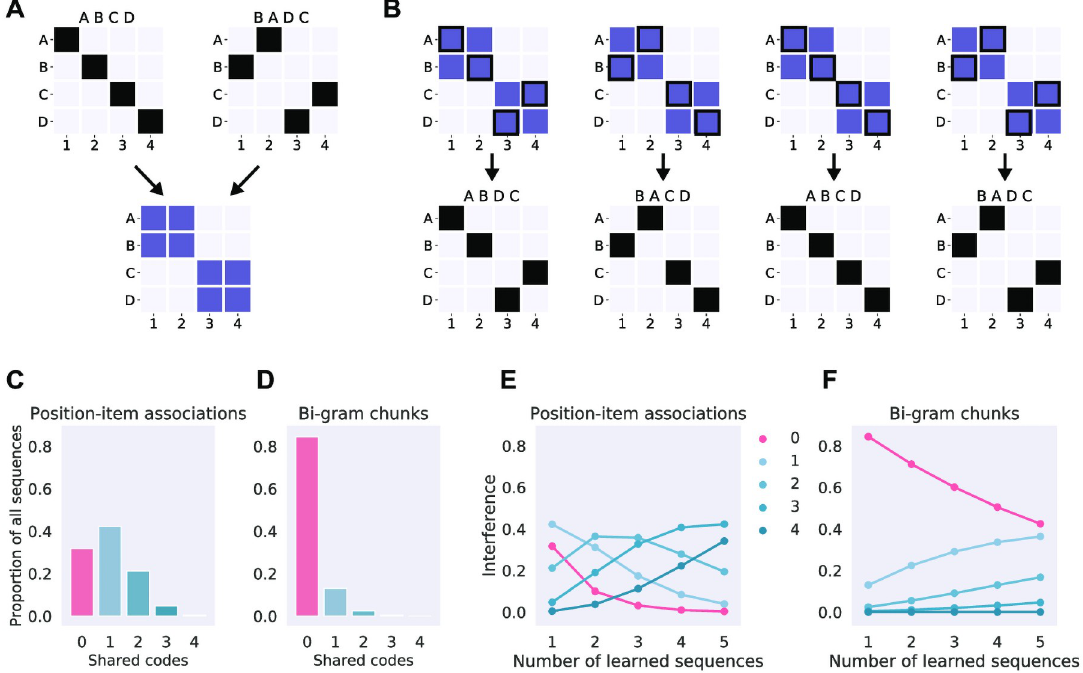
Fig 7. Interference in sequence learning. (A) Visual representation of two sequences as position-item associations (top) and the resulting frequency of associations (bottom) as defined by the associative sequence learning model. (B) Associative learning of two sequences on panel A would boost the representations of four individual sequences despite the statistical regularities being extracted from only two. See S4 Text for a worked example. (C) Histogram of the expected number of shared codes (item-position associations, x- axis) for a single 4-item sequence with all other possible 4-item sequences ( n = 256, allowing repeats), measured as a proportion of sequences sharing the same number of codes (y-axis). (D) Histogram of the shared codes for a two-item (bi-gram) chunk representation. (E) Interference between sequence representations in the item-position model. X-axis displays how many sequences have been learned and lines on the plot display the proportion of other sequences affected by learning as a function of codes shared: the lines correspond to columns in panel C . The red line shows the proportion of sequences which have been unaffected by learning. (F) Interference between sequence representations in the chunk model.